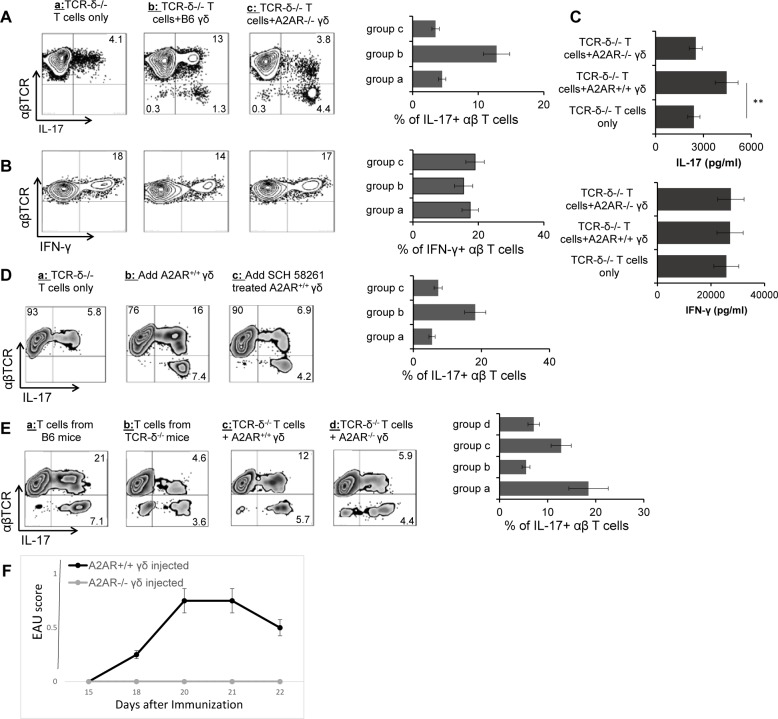
A2AR-/- γδ T cells have a limited enhancing effect on autoimmune responses.A &B) A2AR+/+ enhanced the Th17 response, but A2AR-/- γδ T cells did not; and neither enhanced the Th1 response. A2AR+/+ and A2AR-/- γδ T cells were isolated from immunized wt-B6 or A2AR-/- mice, respectively. Responder αβ T cells (1 x 106/well) prepared from IRBP1-20 immunized TCR-δ-/- mice on day 13 post-immunization were stimulated for 5 days with immunizing antigen and APCs under Th17 (A) of Th1 (B) polarized conditions with or without addition of 2% (2 x 104/well) A2AR+/+or A2AR-/- γδ T cells. The numbers of αβTCR+ IL-17+ and αβTCR+ IFN-γ+ cells were calculated by FACS analysis after a 5-day in vitro stimulation. C) Addition of A2AR+/+ γδ T cells, but not of A2AR-/- γδ T cells, to αβ responder T cells enhanced IL-17 production but did not affect IFN-γ production. Production of IL-17 and IFN-γ by immunized TCR-δ-/- mice was assessed by ELISA, after in vitro stimulation with the immunizing peptide (IRBP1-20), in the presence of A2AR+/+ or A2AR-/- γδ T cells (2%). Cytokine amounts were evaluated in the culture cell supernatants by ELISA after a 48 h stimulation. D) Treatment of A2AR antagonist abolished the enhancing effect of A2AR+/+ γδ T cells. A2AR+/+ γδ T cells were added to responder αβ T cells in culture, with or without a pre-incubation with SCH58261, a selective A2AR antagonist (100nM) [29,30]. Results show that blockade of A2AR ligation abolished the enhancing effect of A2AR+/+ γδ T cells. E) Administration of TCR-δ-/- mice with A2AR+/+γδ T cells, but not with A2AR-/- γδ T cells, enhanced the Th17 response. Groups (n = 4) of TCR-δ-/- mice were injected with A2AR+/+ or A2AR-/- (1 x 106/mouse) γδ T cells, before they were immunized with a pathogenic dose of IRBP1-20/CFA. At 13 days post-immunization, the Th17 responses were assessed 5 days after in vitro stimulation. The results shown are representative of those from five experiments. Differences were considered significant when P ≤ 0.05 (asterisk) and very significant when P ≤ 0.01 (two asterisks). F.) TCR-δ-/- mice injected with A2AR+/+, but not A2AR-/-, γδ T cells were more susceptible to induced EAU. Groups of TCR-δ-/- mice were immunized with IRBP 1-20/CFA with or without a prior injection of 1 x 105 (per mouse) A2AR+/+ or A2AR-/- γδ T cells. EAU was scored as previously reported [3,4,8]. The results of two separate experiments are shown.